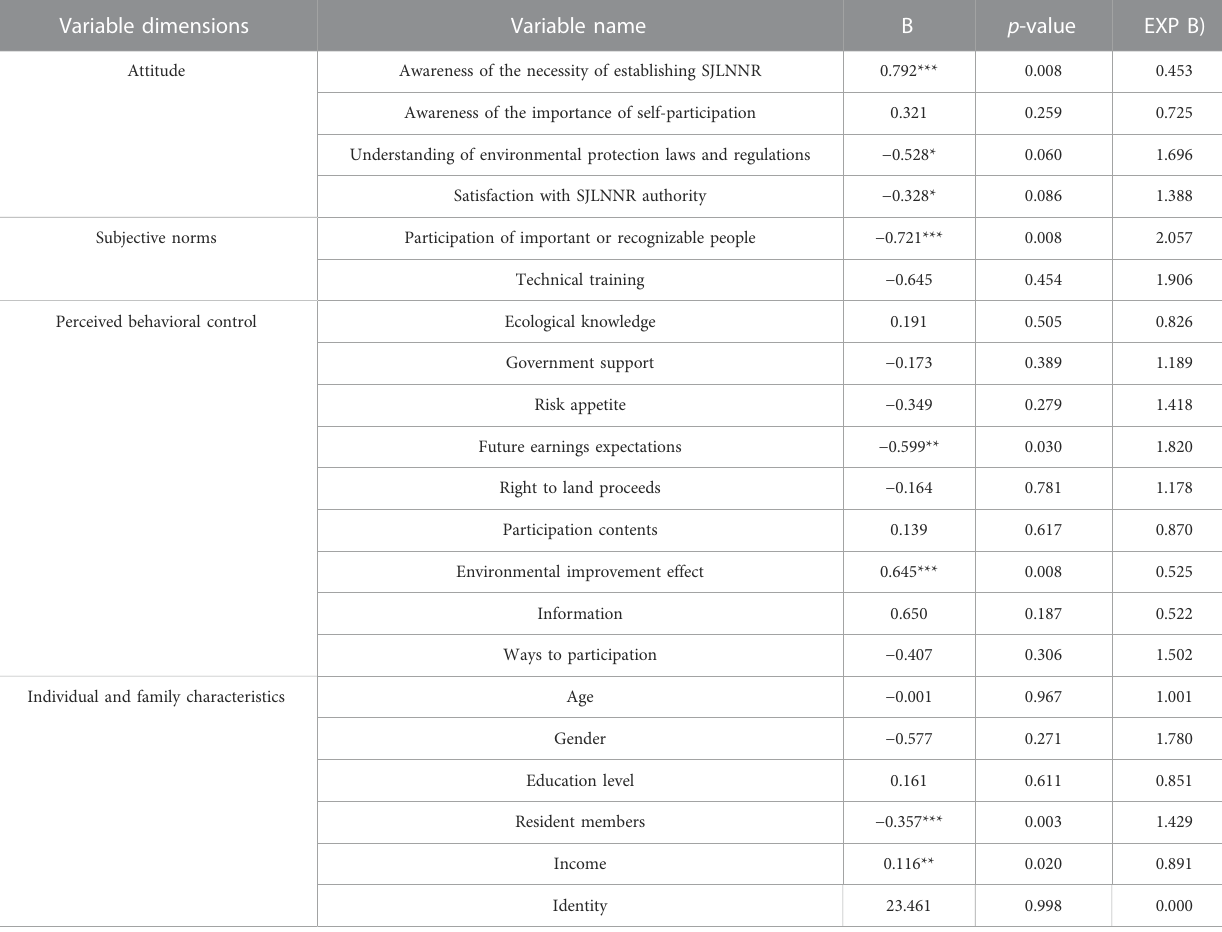
TABLE 5 Results of the logistic regression model. Variable dimensions